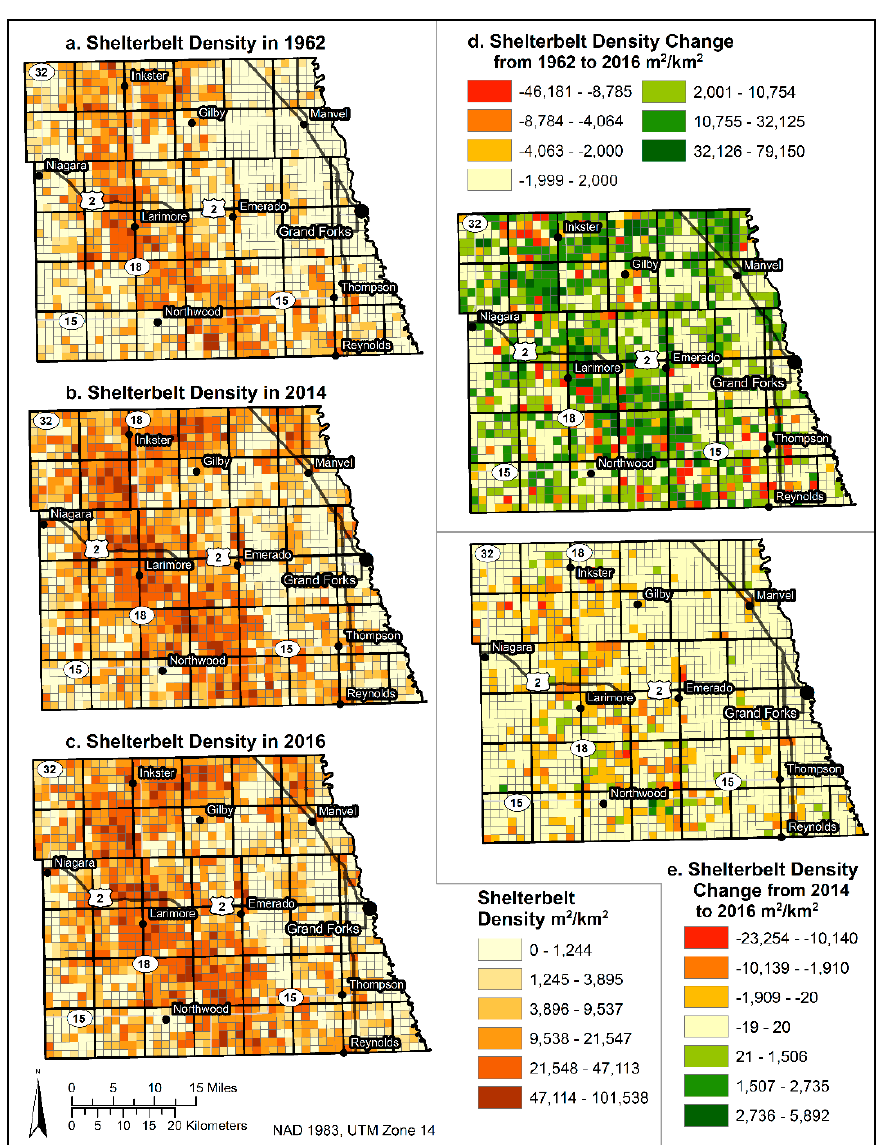
Figure 5. Grand Forks County shelterbelt density measured per section of land for the three years of data: ( a ) 1962, ( b ) 2014, and ( c ) 2016, as well as the change in shelterbelt density ( d ) 1962–2016, and ( e ) 2014–2016.